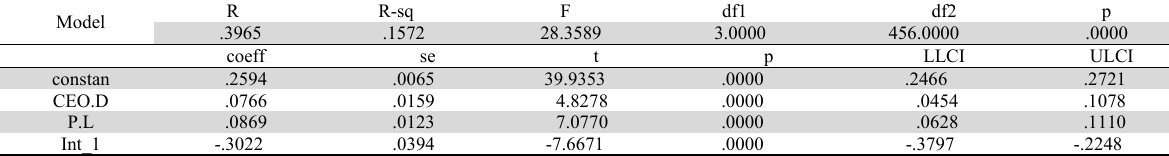
Model Summary of the Moderating Effect of Political Links on the Relationship Between CEO Duality and CER Practices R R-sq F df1 df2 Model